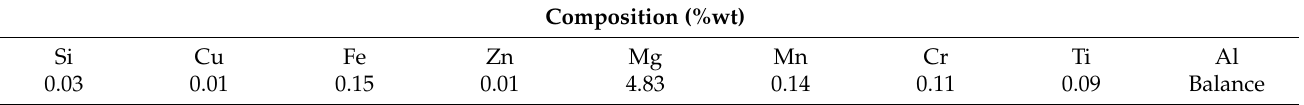
Table 1. Chemical composition of the ER5356 aluminum wire (in weight percentage).